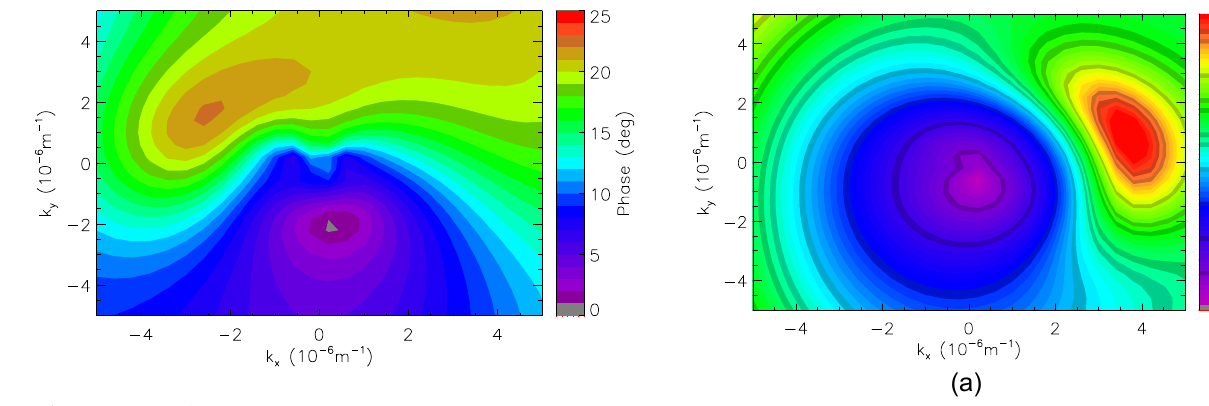
Fig. 4. The differential phases for noon and summer at L=1.6 (South Hemisphere) for a 70MHz signal due to changes in TEC from a 50mHz ULF wave as a function of the ULF wave spatial scale size. The ionosphere and neutral atmosphere parameters are the same as those used for Fig. 1. The upper boundary wave mode mix is 80% shear Alfv´en mode.